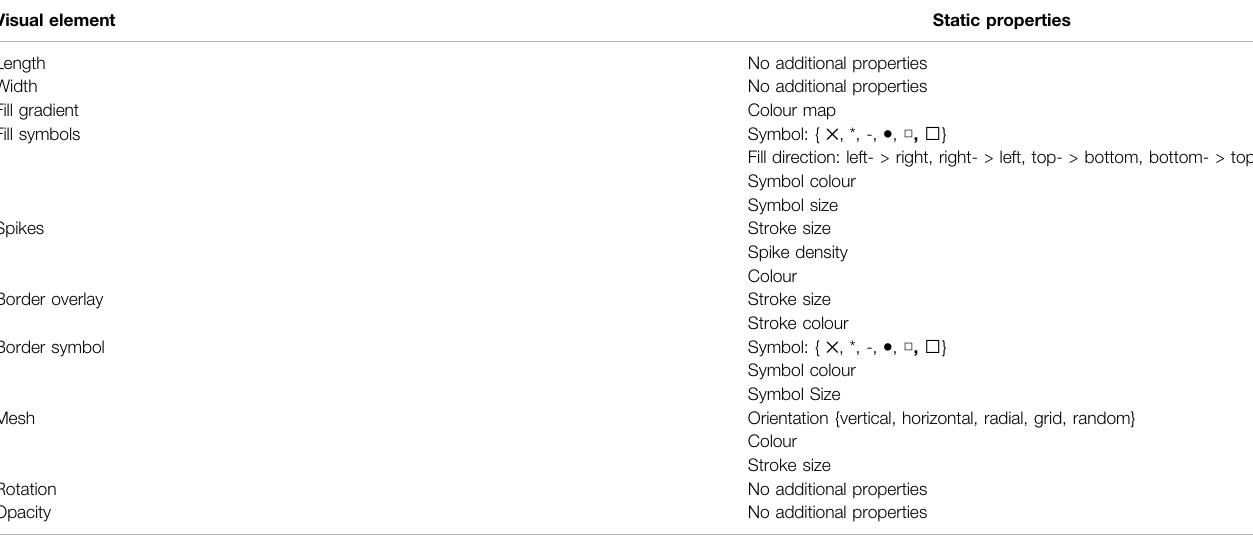
TABLE 1 | Customisable properties of ShapoGraphy elements. Visual